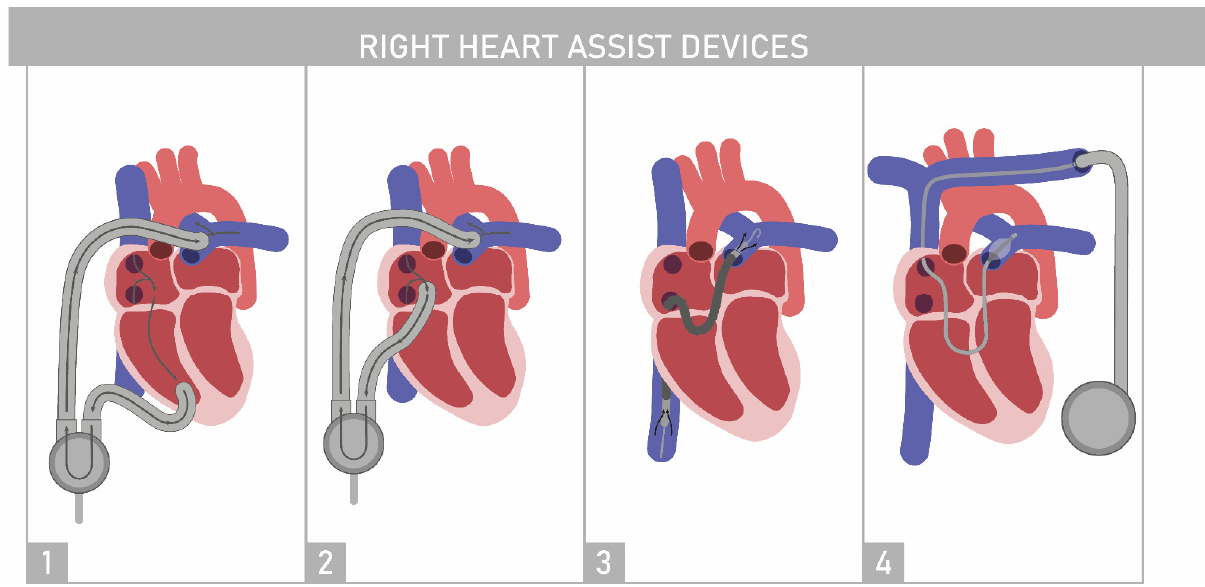
Figure 2. Right heart assist devices: ( 1 ) right ventricular assist device with right ventricular sourcing, ( 2 ) right ventricular assist device with right atrial sourcing, ( 3 ) the Impella RP heart pump (Abiomed, Danvers, MA, USA), and ( 4 ) the Aria CV PH system (Aria CV, Inc. Saint Paul, MN, USA).